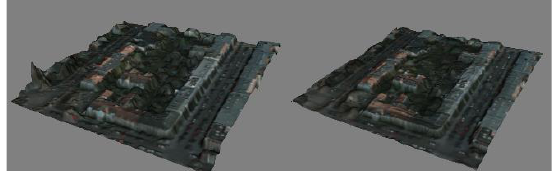
Figure 6. Qualitative example of 3D reconstruction on Potsdam dataset. Ground truth (left) and restored model (right).